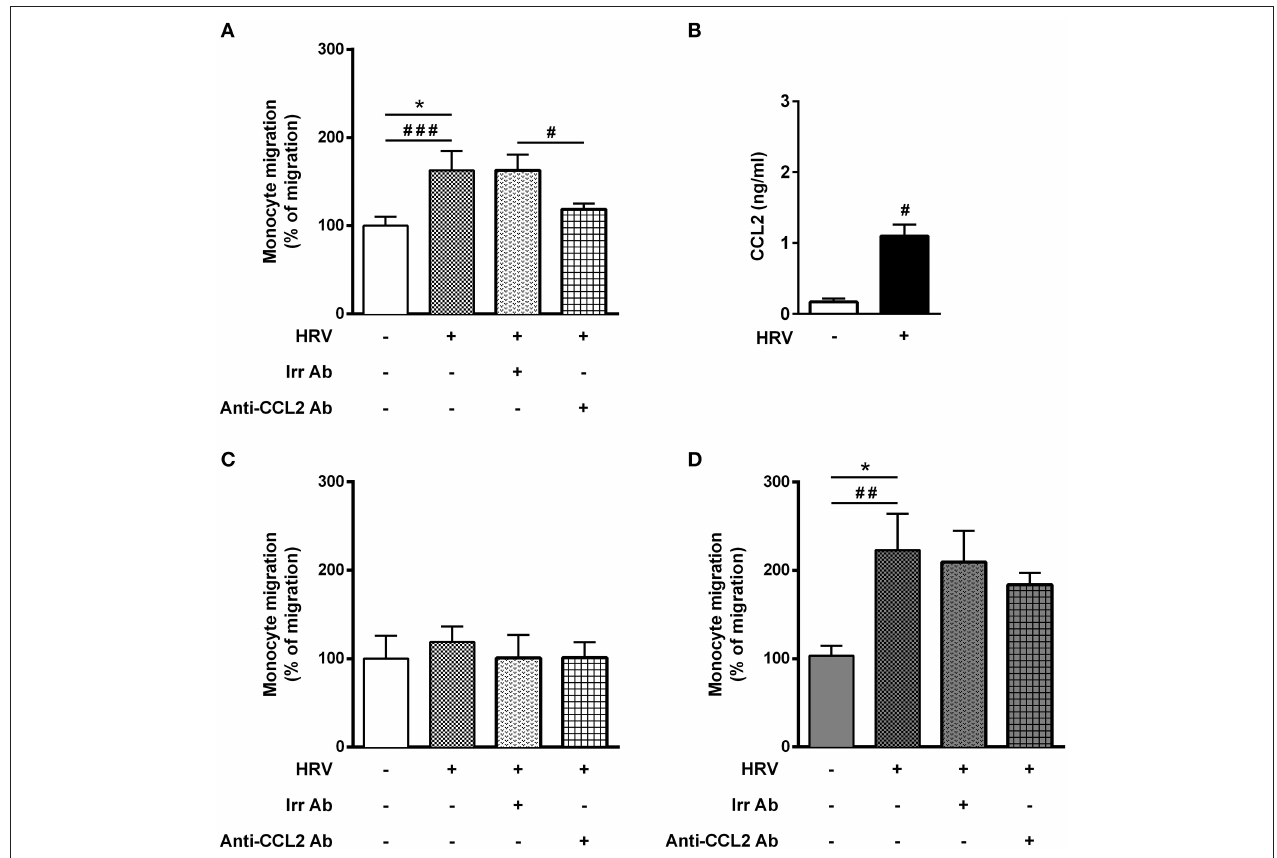
FIGURE 1 | Asthmatic bronchial smooth muscle cell co-culture increases rhinovirus-mediated monocyte migration. (A) Monocyte migration was assessed in response to supernatants of reconstituted bronchial epithelial cells in air liquid interface infected or not with human rhinovirus (HRV-16; at MOI 0.1 for 1h). The effect of CCL2 on rhinovirus-induced monocyte migration was evaluated by addition of blocking antibody ( n = 7–11 per group). (B) CCL2 proteins were assessed from epithelial cell supernatant ( n = 5 per group). (C) Monocyte migration was assessed in response to supernatants of reconstituted bronchial epithelial cells in air liquid interface co-cultured for 1 week with bronchial smooth muscle cells from control ( n = 5–9 per group) or (D) asthmatic patients ( n = 5–8 per group). Data are presented as mean ± SEM values of three independent experiments (Wilcoxon test, # P < 0.05; ## P < 0.01; ### P < 0.001 and ordinary one way anova, Bonferroni’s multiple comparisons test, * P < 0.05 compare the mean of HRV + alone with the mean of every other columns).